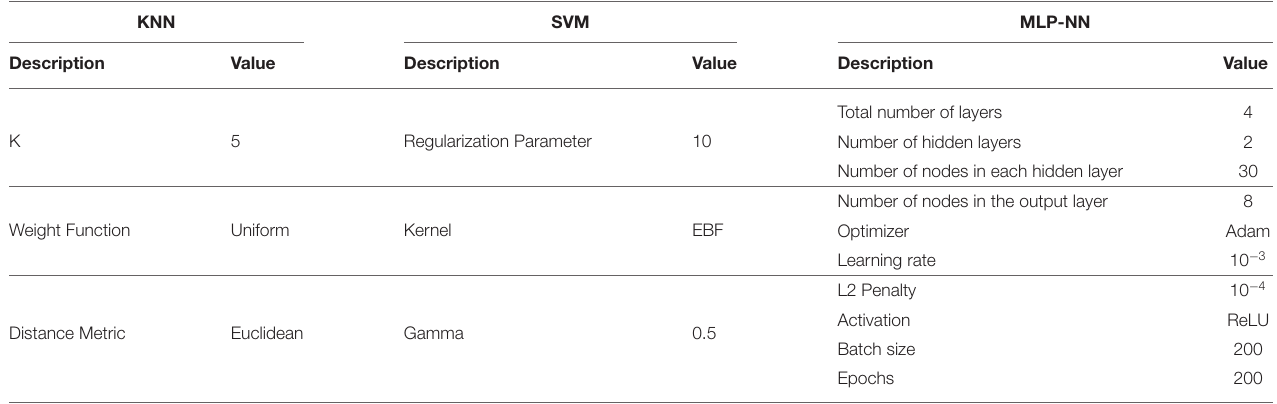
FIGURE 6 | Validation curve for KNN obtained using 5-fold cross validation of data. The parameter K is varied from 1 to 20. The value of K at which a KNN model yields high training accuracy as well as high validation accuracy is the optimum value of K for the dataset. K = 1 leads to overfitting as in that case the training accuracy is 1 but the validation accuracy is very low. The validation curve suggests that the best possible KNN model that one can obtain for our dataset is for K = 5. Blue and orange line represent training set accuracy and validation set accuracy, respectively.